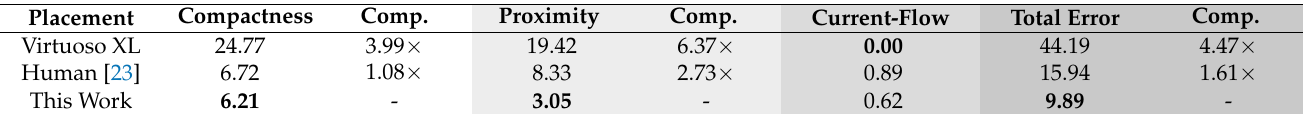
Figure 5. Generated placements, instantiated in Cadence. From left to right, generated by: the proposed toolbox, Virtuoso XL and expert designer. Table 1. Floorplans’ error comparison for the current starving single-stage amplifier biased by